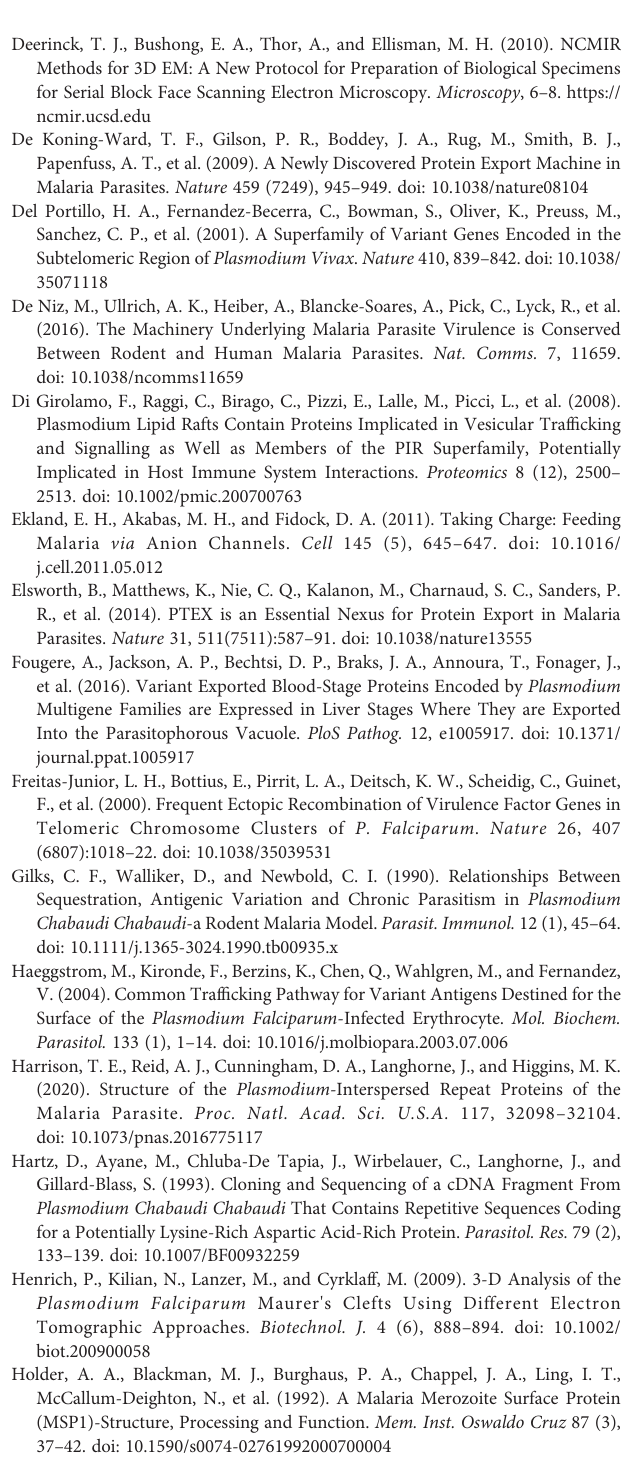
Supplementary Figure S6 | Western blot analysis of fractionated protein samples of P. c. chabaudi SBP acute-phase parasites at the trophozoite-stage. Supplementary Table 1 | P. chabaudi PIR clade peptide motifs and BlastP results against clade members.